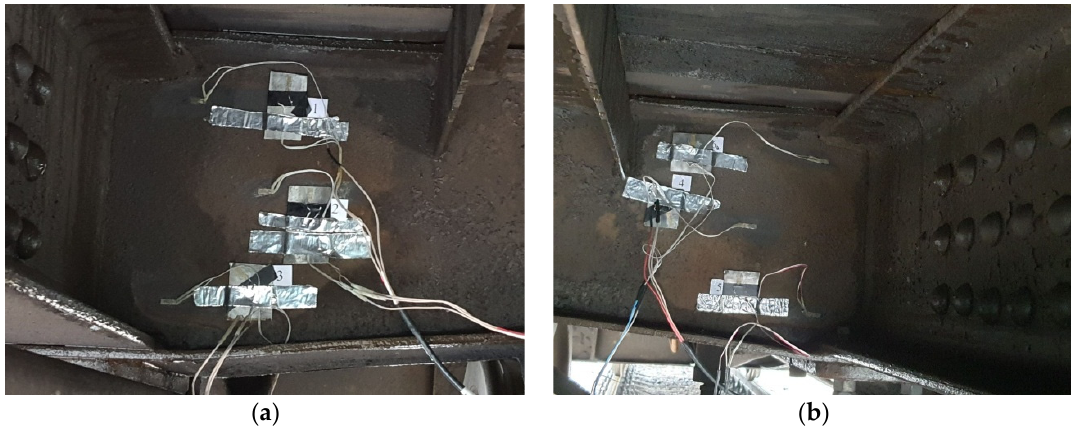
Figure 10. Strain gauges on the body bolster: ( a ) left sheet; ( b ) right sheet.